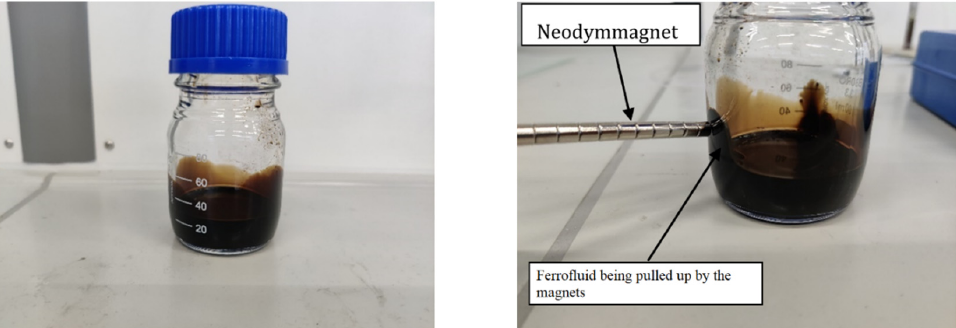
Figure A4. Aqueous ferrofluid (tetramethylammonium hydroxide) after preparation ( left ). The reaction of the same ferrofluid after 3 weeks of standing under the influence of a neodymium magnet ( right ).